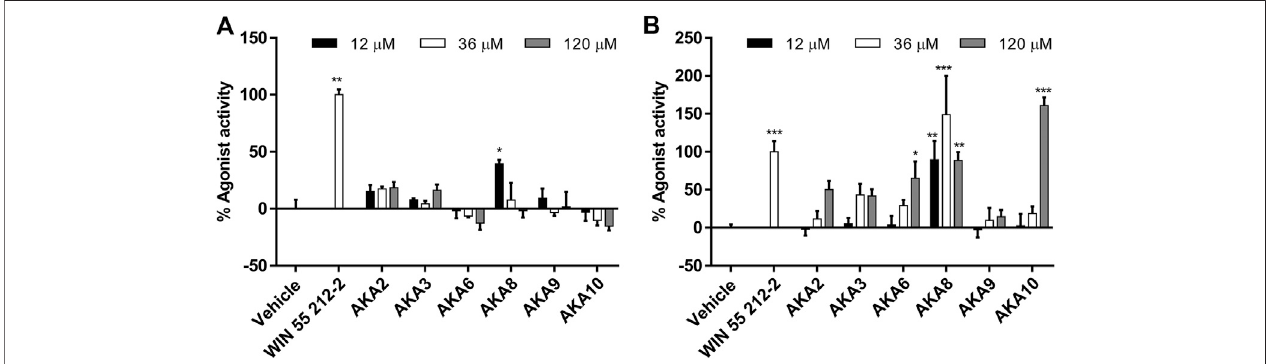
FIGURE3| MeanagonisteffectsofisolatedEchinaceaalkylamides(AKA)onCB1 (A) andCB2 (B) receptorinCBreceptorredistributionassays,expressedrelative to the positive control WIN 55,212-2 (1 µm). An analysis of variance (ANOVA) was performed to evaluate the variance between samples followed by Dunnett ’ s test post